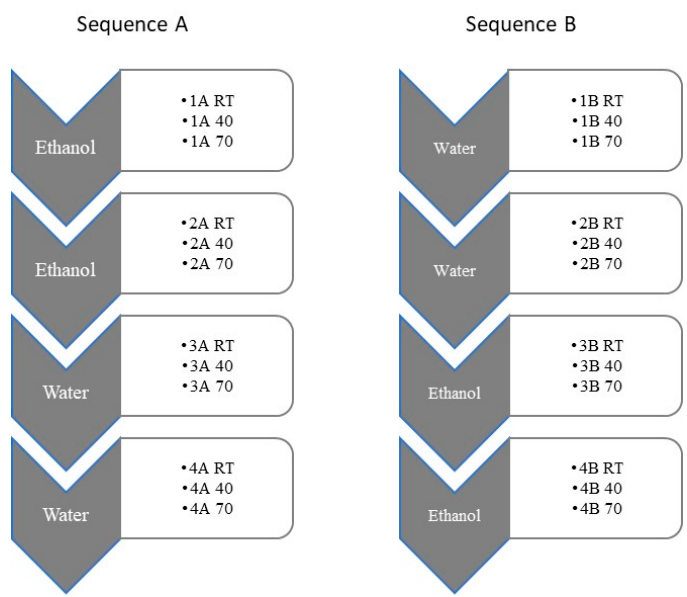
Figure 1. Representative scheme of the two sequences of extraction (A and B) with different sol- vents (ethanol or water), temperatures (room temperature (RT); 40 ◦ C; 70 ◦ C), and the respective extracts